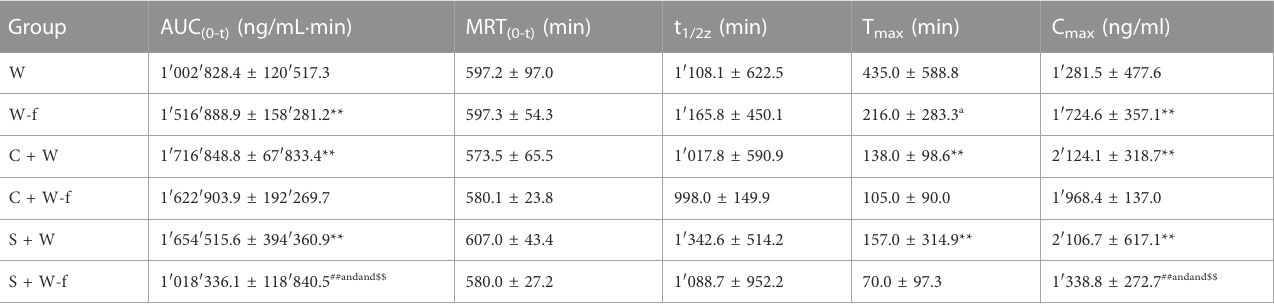
TABLE 1 The pharmacokinetics parameters of warfarin (mean ± SD, n = 8).